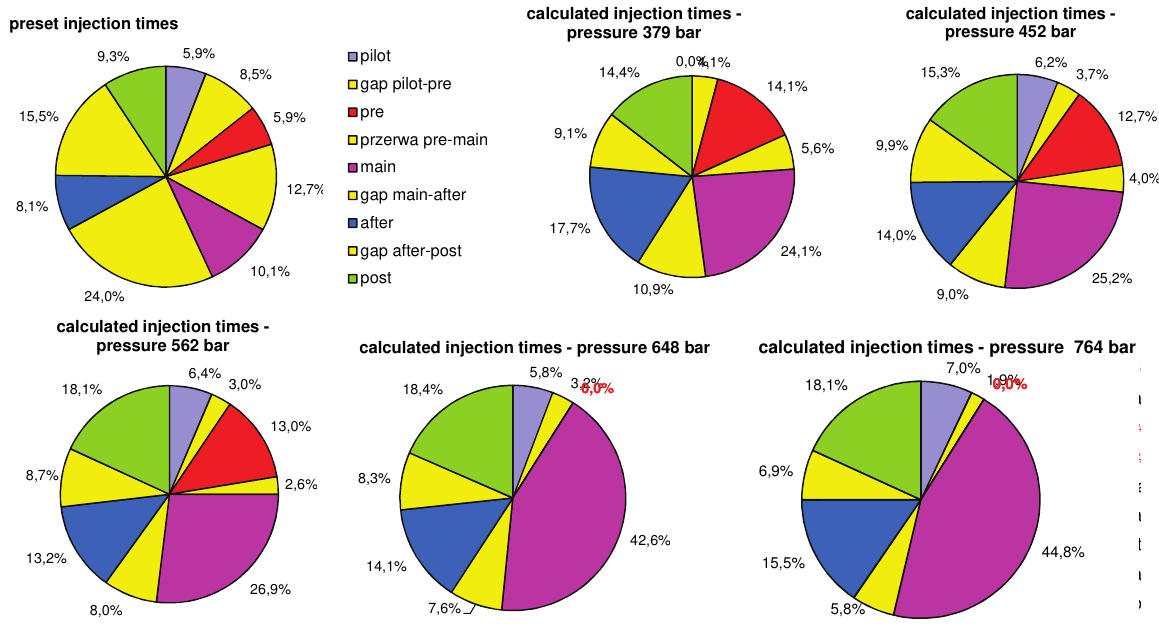
Fig. 12. Percentage shares of calculated times of individual portions and gaps in total, complete injection time for the third group of the measurements